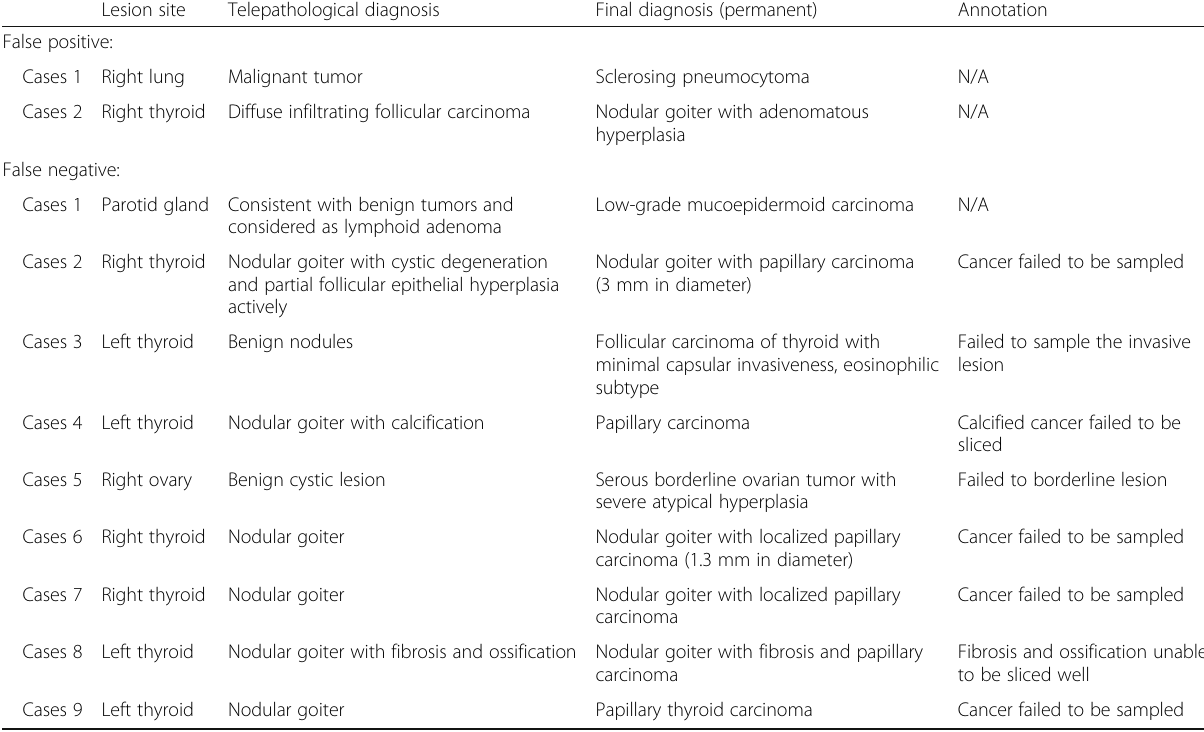
Table 3 In concordance cases of intraoperative frozen sections from the TP platform Lesion